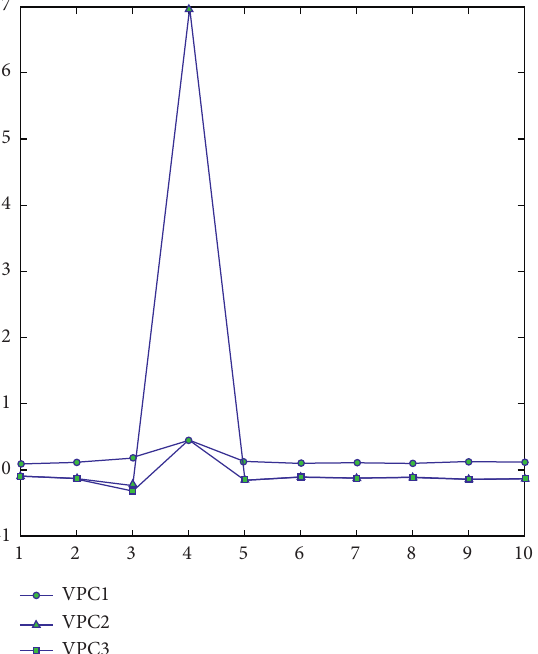
Figure 5: Feature extracting for digit “3” in MNISTdata by vector-based KPCA. The vertical axis shows projection values of 10 samples onto the kernel principal